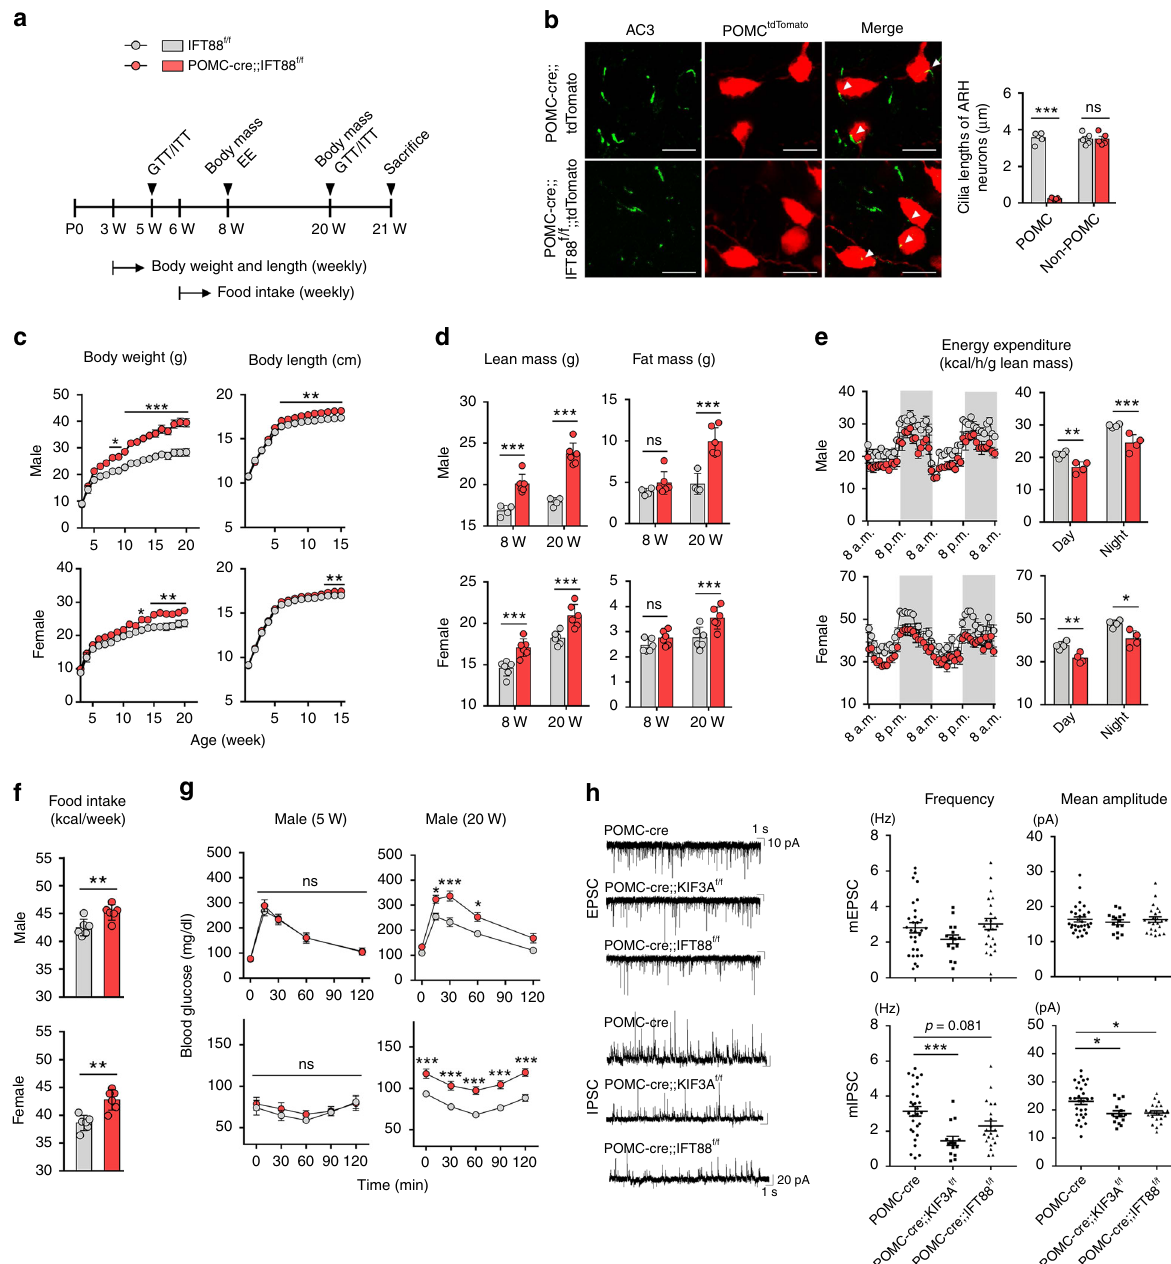
Fig. 2 Inhibition of ciliogenesis in the developing POMC neurons causes obesity and glucose dysregulation in adulthood. a Experimental scheme in mice with POMC-speci fi c IFT88 depletion that commenced from E11 – E12. b Representative cilia images and measurement of cilia lengths in the ARH of POMC-cre;;IFT88 f/f ;;tdTomato mice and age-matched POMC-cre;;tdTomato mice ( n = 5). Arrowheads indicate cilia of POMC tdTomato neurons. Scale bars: 20 μ m. c Body weights and body lengths of POMC-cre;;IFT88 f/f and IFT88 f/f male and female mice (body weights: n = 6 for POMC-cre;;IFT88 f/f males and n = 4 for the other 3 groups, body lengths: n = 7). d Lean mass and fat mass measured at 8 and 20 weeks ( n = 4 for IFT88 f/f males, n = 6 for the other 3 groups). e Energy expenditure determined at 8 weeks ( n = 4). f Average values of weekly food intake during 6 – 20 weeks ( n = 6). g Glucose and insulin tolerance tests performed at 5 and 20 weeks ( n = 5). h Patch clamp recordings showing the frequency and mean amplitude of the miniature excitatory postsynaptic currents (mEPSCs) and the miniature inhibitory postsynaptic currents (mIPSCs) in the POMC neurons lacking KIF3A or IFT88 (EPSC recording: n = 30 for POMC-cre mice, n = 15 for POMC-cre;;KIF3A f/f mice, n = 23 for POMC-cre;;IFT88 f/f mice; IPSC recording: n = 29 for POMC-cre mice, n = 14 for POMC-cre;;KIF3A f/f mice, n = 21 for POMC-cre;;IFT88 f/f mice). Data are presented as the mean ± SEM values. Statistics were performed using two-sided Student ’ s t test ( b , d – f ), one-sided two-way ANOVA ( c , g ) and one-sided one-way ANOVA ( h ) followed by post hoc LSD test and. * p < 0.05, ** p < 0.01, *** p < 0.001 vs. IFT88 f/f controls. ns not signi fi